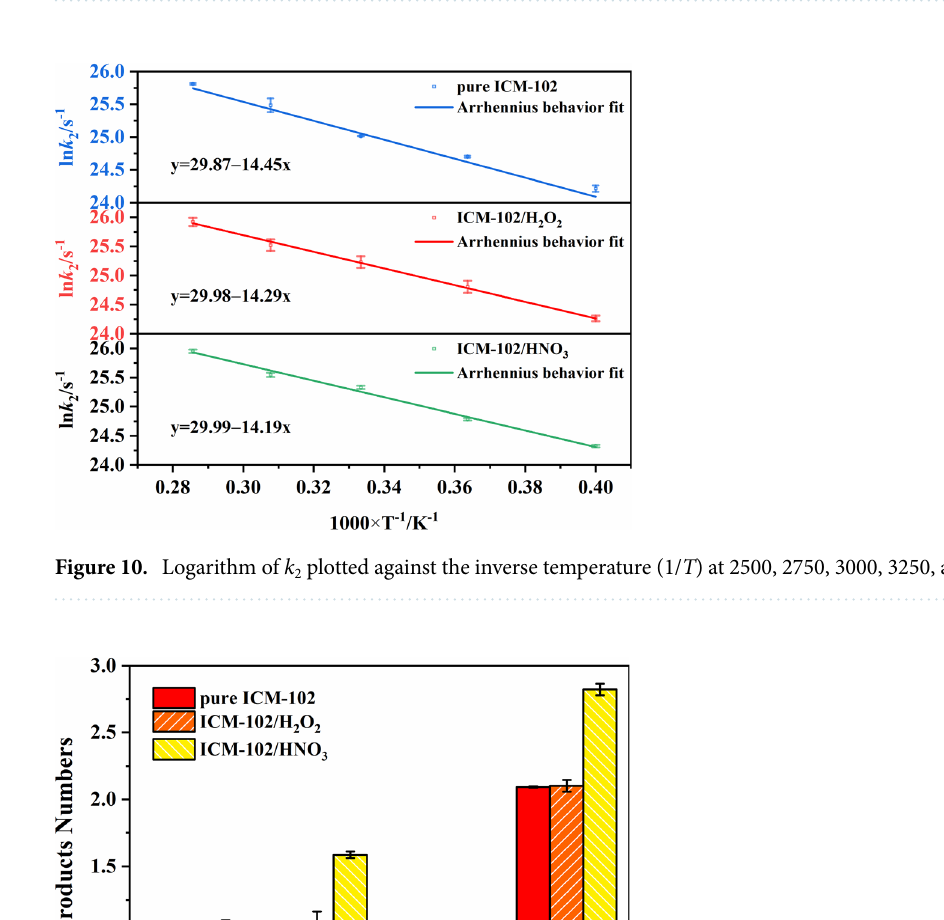
Figure 9. Evolution of the PE with time for the pure ICM-102, ICM-102/H 2 O 2 , ICM-102/HNO 3 systems at 3000 K. The lines are the fitted curves.